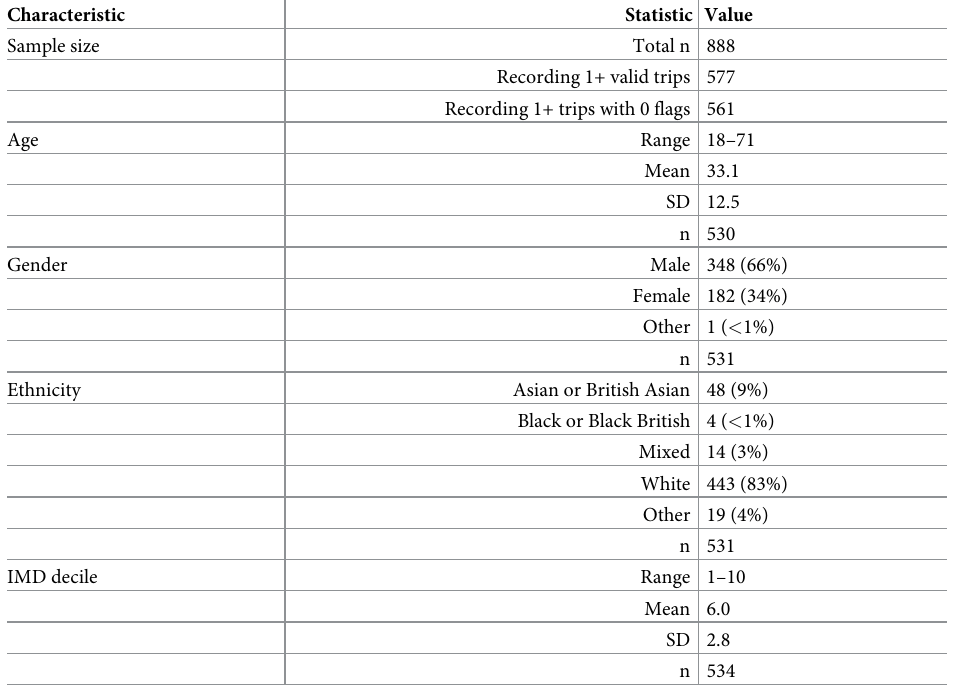
Table 1. Demographics of Shmapped users recording at least one valid